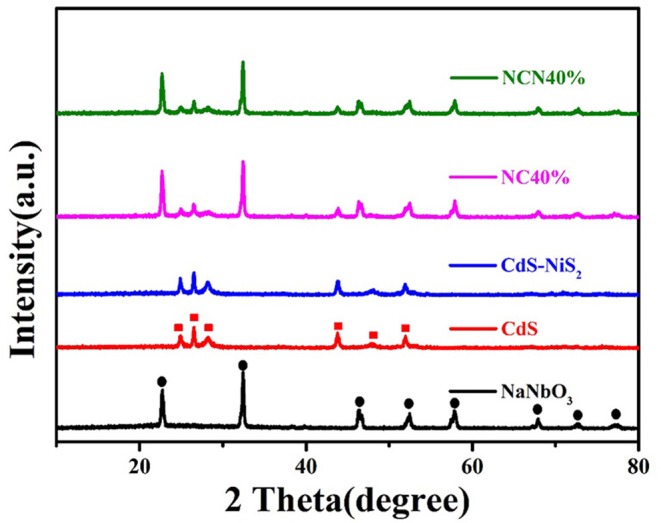
XRD patterns of NaNbO3, CdS, CdS-NiS2, NC40%, and NCN40%.